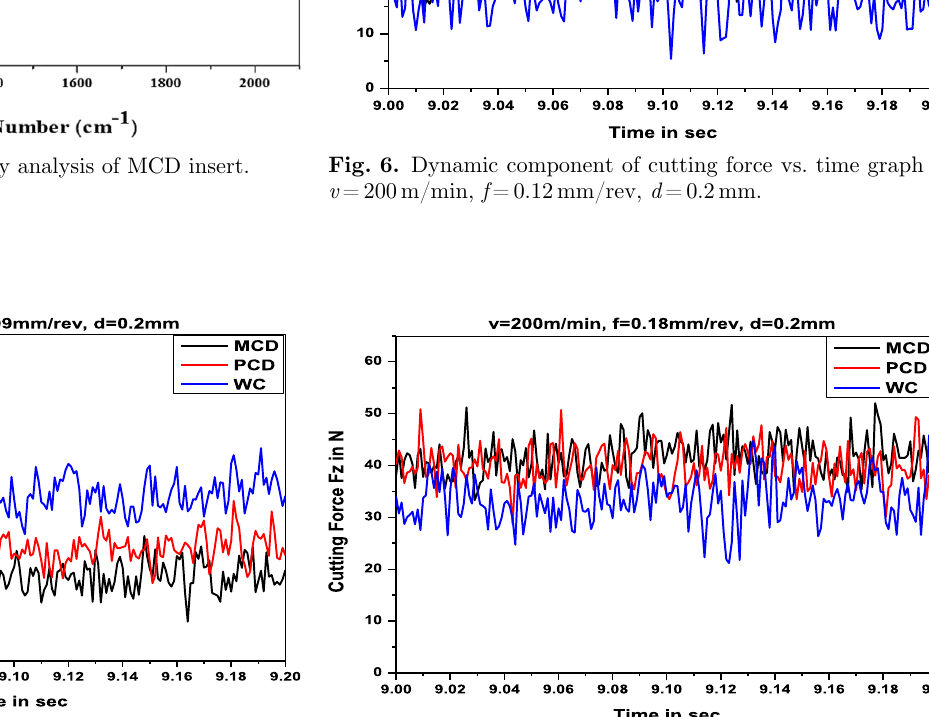
Fig. 5. Dynamic component of cutting force vs. time graph at v = 200m/min, f =0.09 mm/rev, d = 0.2mm.